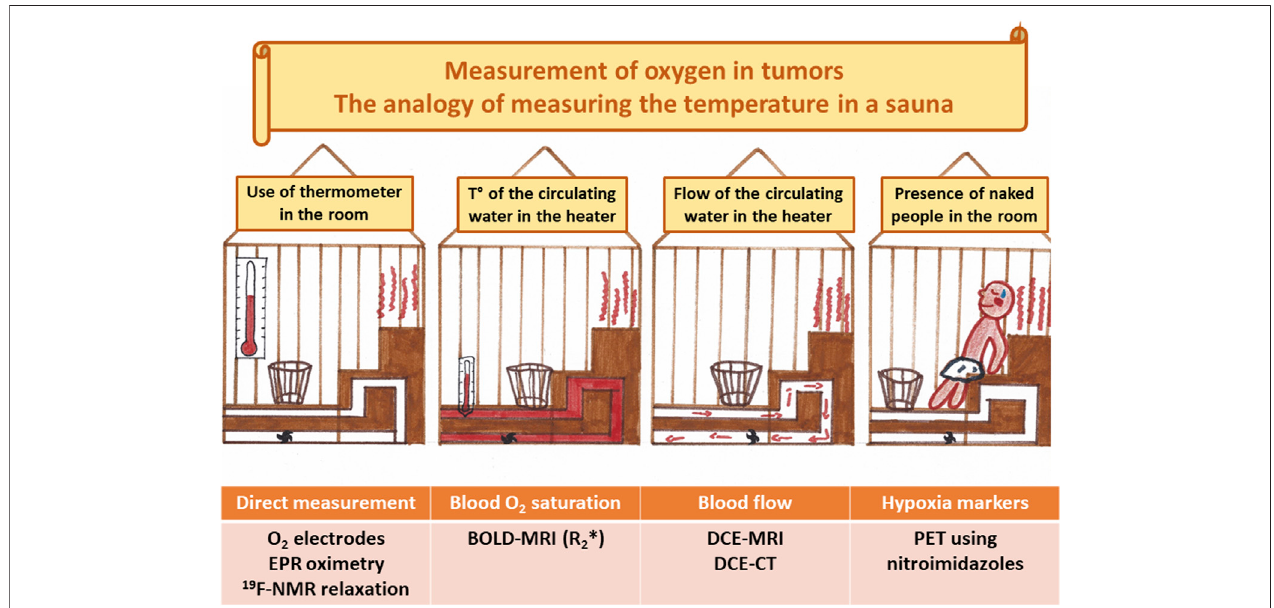
FIGURE 9 | Comparison between measuring tumor oxygenation with hypoxia biomarkers and measuring temperature in a sauna. The direct way to measure the temperature is to use a thermometer. Translated in the hypoxia world, it corresponds to direct measurements of tissue oxygenation (pO 2 histography, optic fi bres, EPR oximetry, 19 F-relaxometry). Another approach is to measure the temperature of the circulating water in the heater. Caution: we do not know if the door is open. This approach is analog to the measurements done using the oxygen blood saturation (R 2 * or BOLD-MRI). It provides information on the oxygen delivery through the blood. Another approach is to measure the fl ow of the circulating water in the heater. Caution: we do not know if the door is open and if the circulating water is hot. It is comparablewithDCE-MRI.Themethodonlyconsidersthedelivery,noinformationisprovidedregardingtheoxygenation.Finally,wemaylookforthepresenceofnaked (or almost) people in the room. While we do not know the temperature, their presence likely means a hot temperature inside the sauna. This situation is analog to the accumulation of nitroimidazoles inside hypoxic cells. We do not know the real oxygenation of the tissue, but it is likely hypoxic.